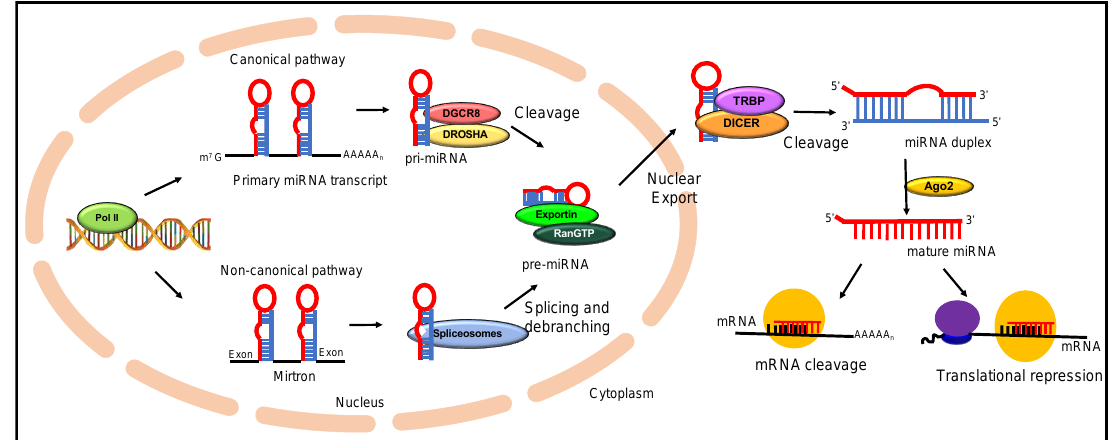
Figure 1. A schematic illustrating the miRNA biogenesis and its regulation of gene expression by post-transcriptional inactivation.